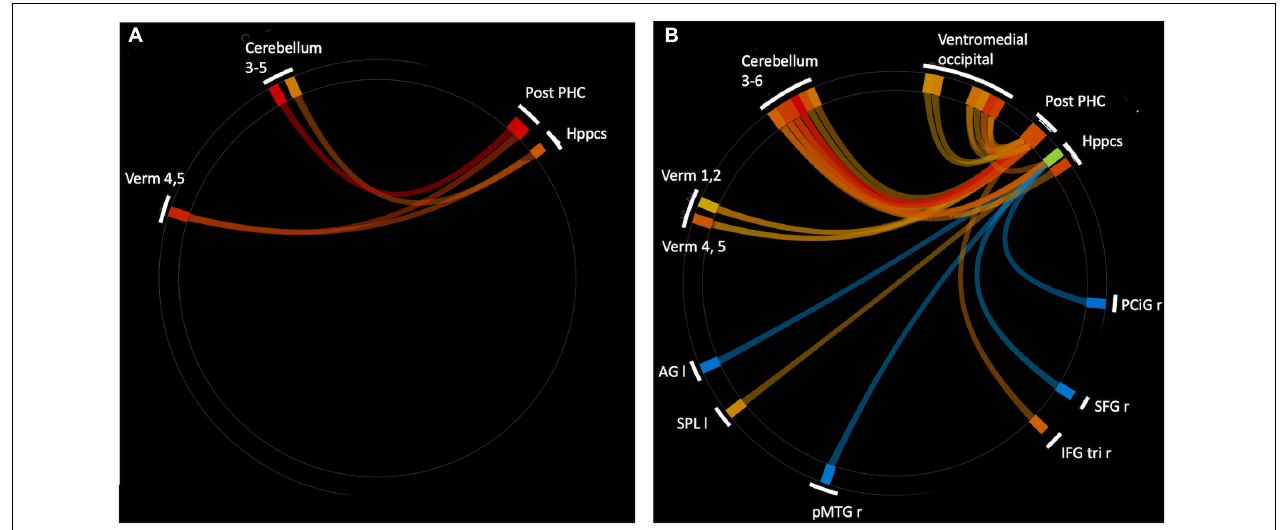
FIGURE 2 | ROI-to-ROI analysis using hippocampal and parahippocampal cortex (anterior and posterior) seeds. (A) Significantly strengthened connections for aged users vs. aged non-users. There were no connections that were significantly stronger for aged non-users vs. users. (B) Significantly altered connections for younger (18–35 years) vs. older (60+ years) non-users. Warm colors indicate young > old, cool colors indicate old > young. Ventromedial occipital includes occipital fusiform, temporal occipital fusiform, and posterior temporal occipital fusiform. Abbreviations: r, right; I, left; Verm, vermis; Post-PHC, posterior parahioppocampal cortex; Hppcs, hippocampus; PCiG, paracingulate gyrus; SFG, superior frontal gyrus; IFG tri, interior frontal gyrus, pas triangularis; pMTG, middle temporal gyrus, posterior division; SPL, superior parietal lobule; AG, angular gyrus.